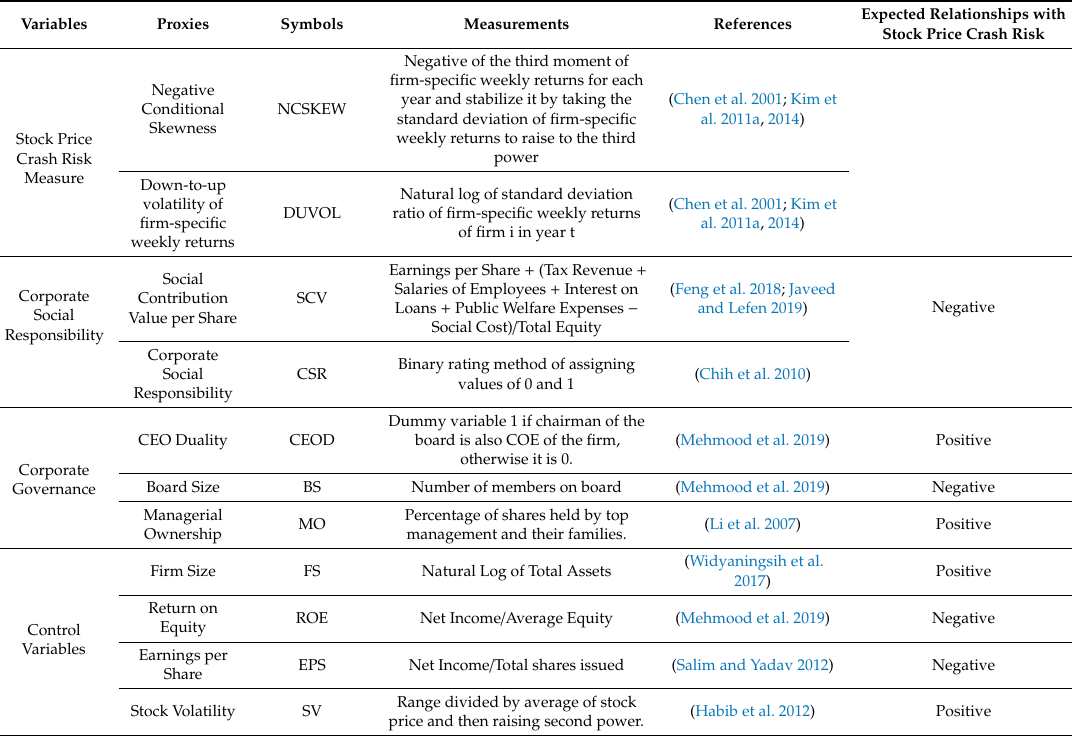
Table 1. Variables and their